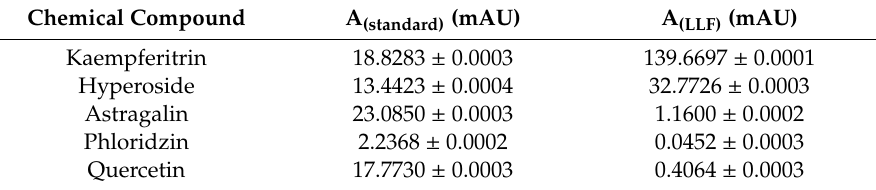
Table 4. Composition of lotus leaf flavonoids.